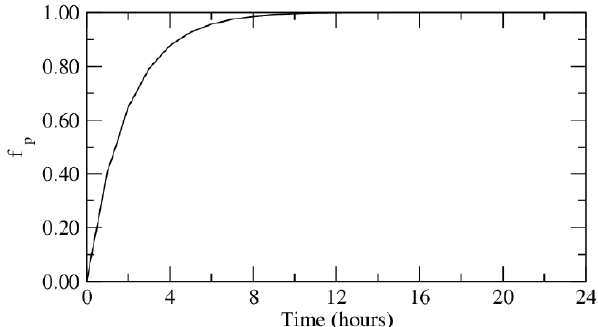
Figure 7. Function defined to moderate the mineral dust emissions fluxes after a precipitation